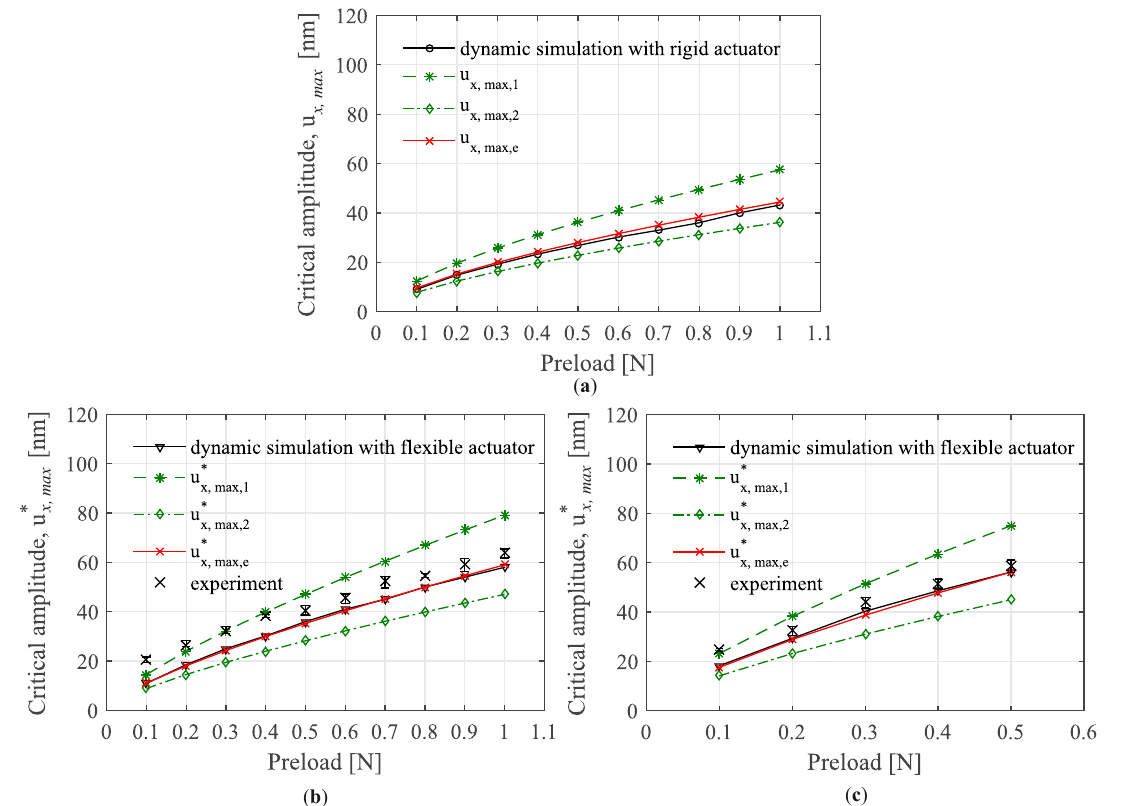
Figure 6. Simulations of the critical amplitude phenomenon using six-contact model and its relation to u x , max : ( a ) ideally rigid actuators with the radius of the hemispheres R = 1 mm; ( b ) flexible actuators with the radius of the hemispheres R = 1 mm; ( c ) flexible actuators with the radius of the hemispheres R = 0.25